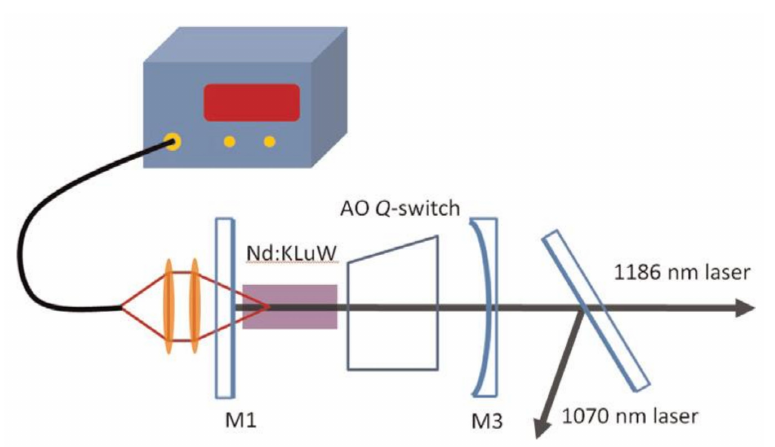
Figure 6. Schematic diagram of the actively Q-switched Yb:KLuW self-Raman laser